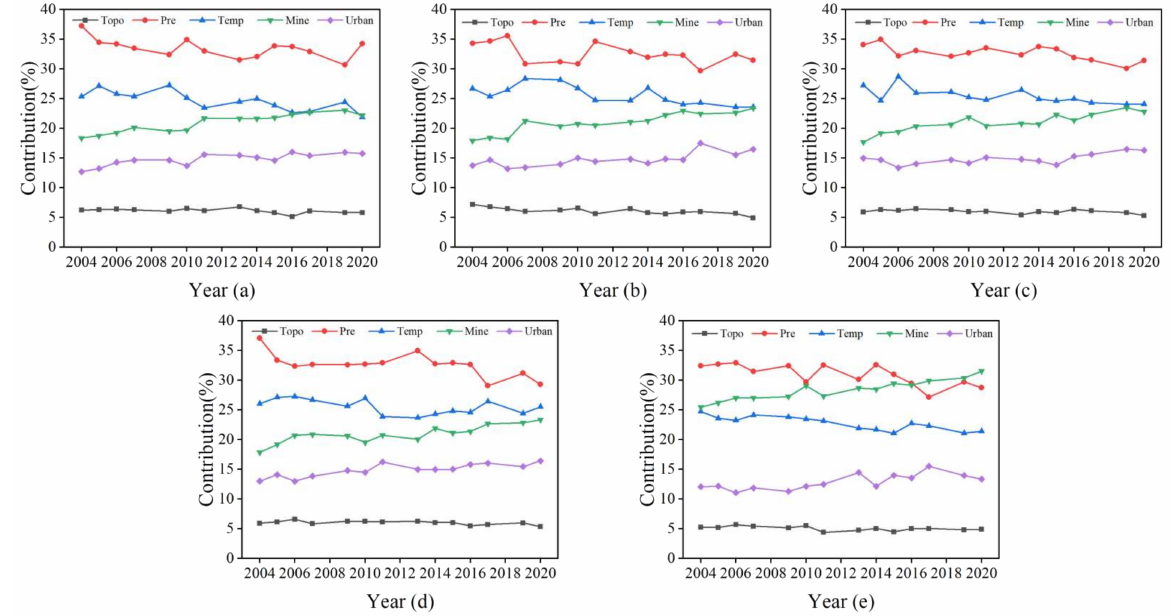
Figure 10. The contribution of driving factors from 2004 to 2020. ( a – e ): Directions 1–5. Topo represents the factor of topography; Pre represents the factor of precipitation; Temp represents the temperature factor; Mine represents the factor of mining, and Urban represents the factor of urban